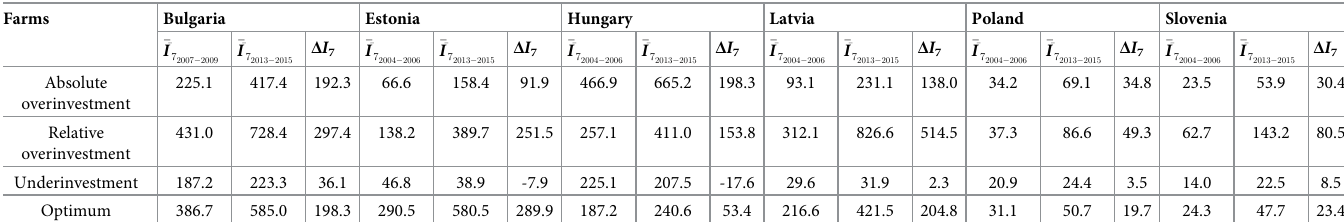
Table 8. Total production costs (EUR thousand per farm) in farms grouped by scale of investment in 2007–2009 and 2013–2015 ( I 7 ). Farms Bulgaria Absolute 225.1 overinvestment Relative overinvestment Underinvestment Optimum Source: own calculations based on unpublished EU-FADN–DG AGRI data.